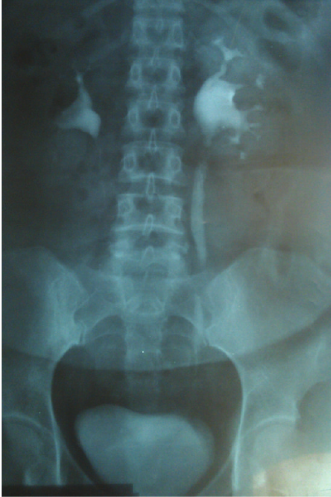
Figure 1: Excretory urography showed dilatation of left ureter.